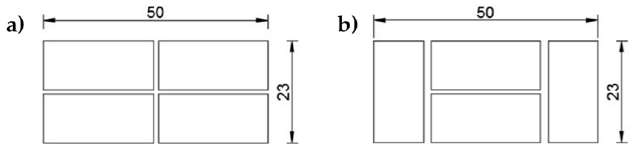
Figure 34. Arrangement of the bricks in the rows (all measures in cm ): ( a ) odd rows and ( b ) even rows.